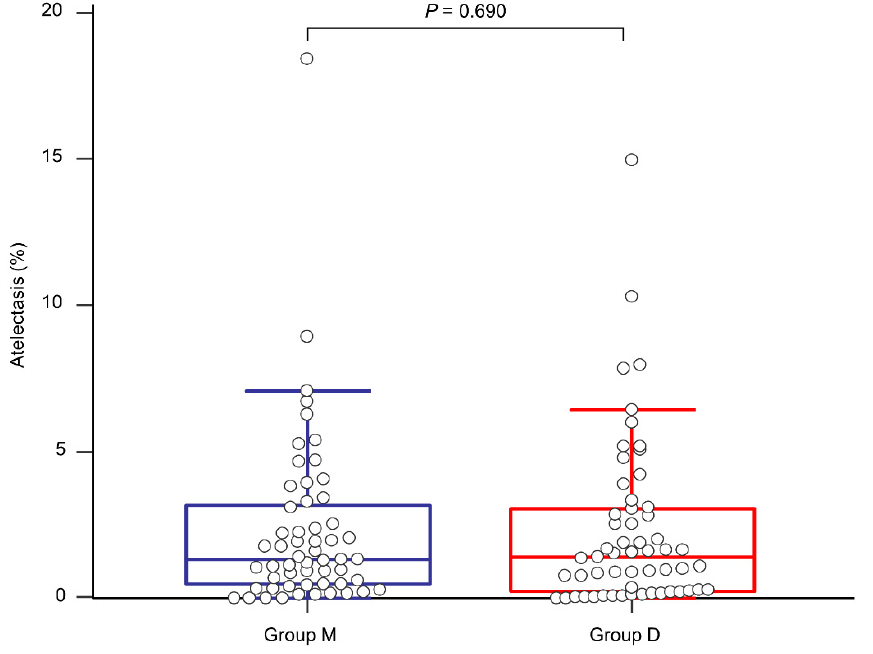
Figure 4. Comparison of the proportion of postoperative atelectasis between group M (blue line) and group D (red line). Table 3. Postoperative data.